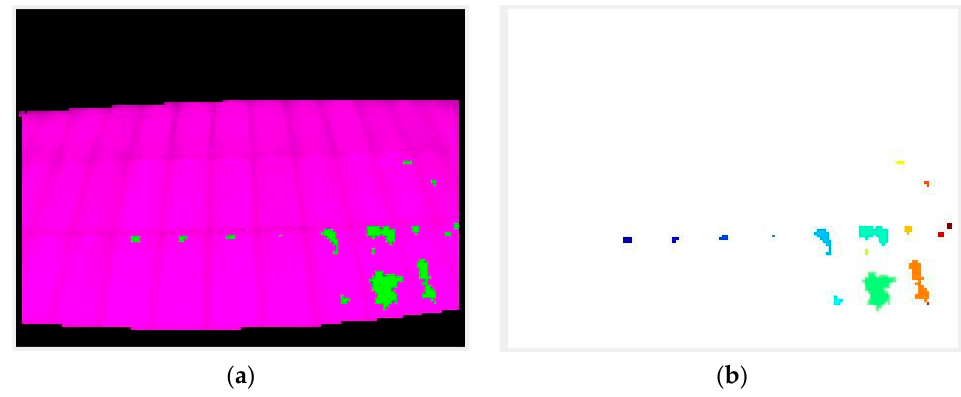
Figure 10. Result of the segmentation and labeling of the hot-spots. ( a ) Segmentation; (b) Neighbor- ing.